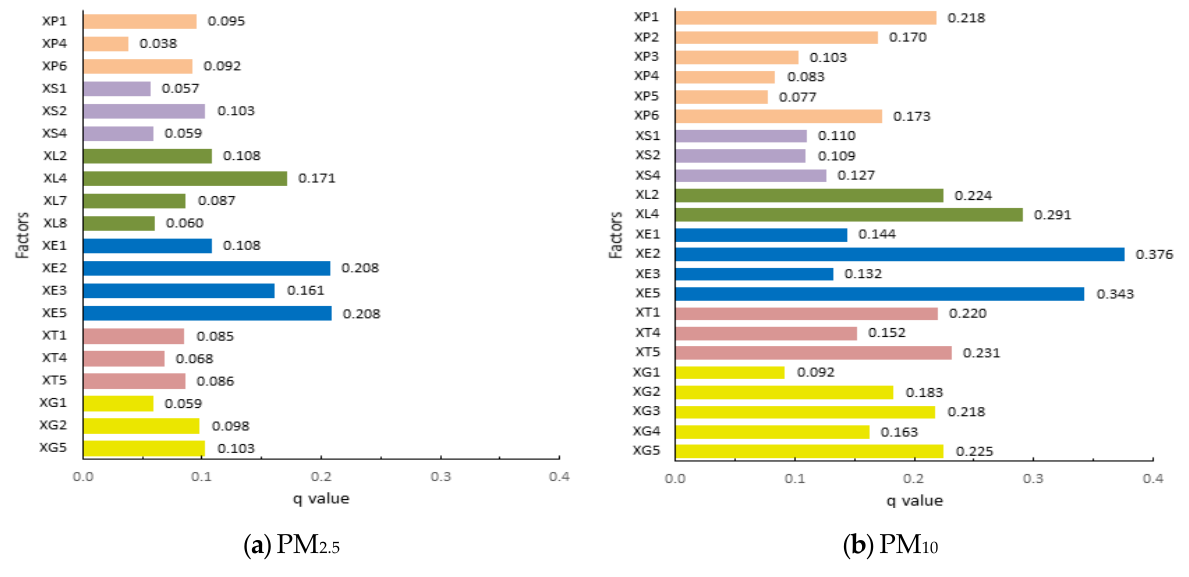
Figure 6. q statistics for factor detector.